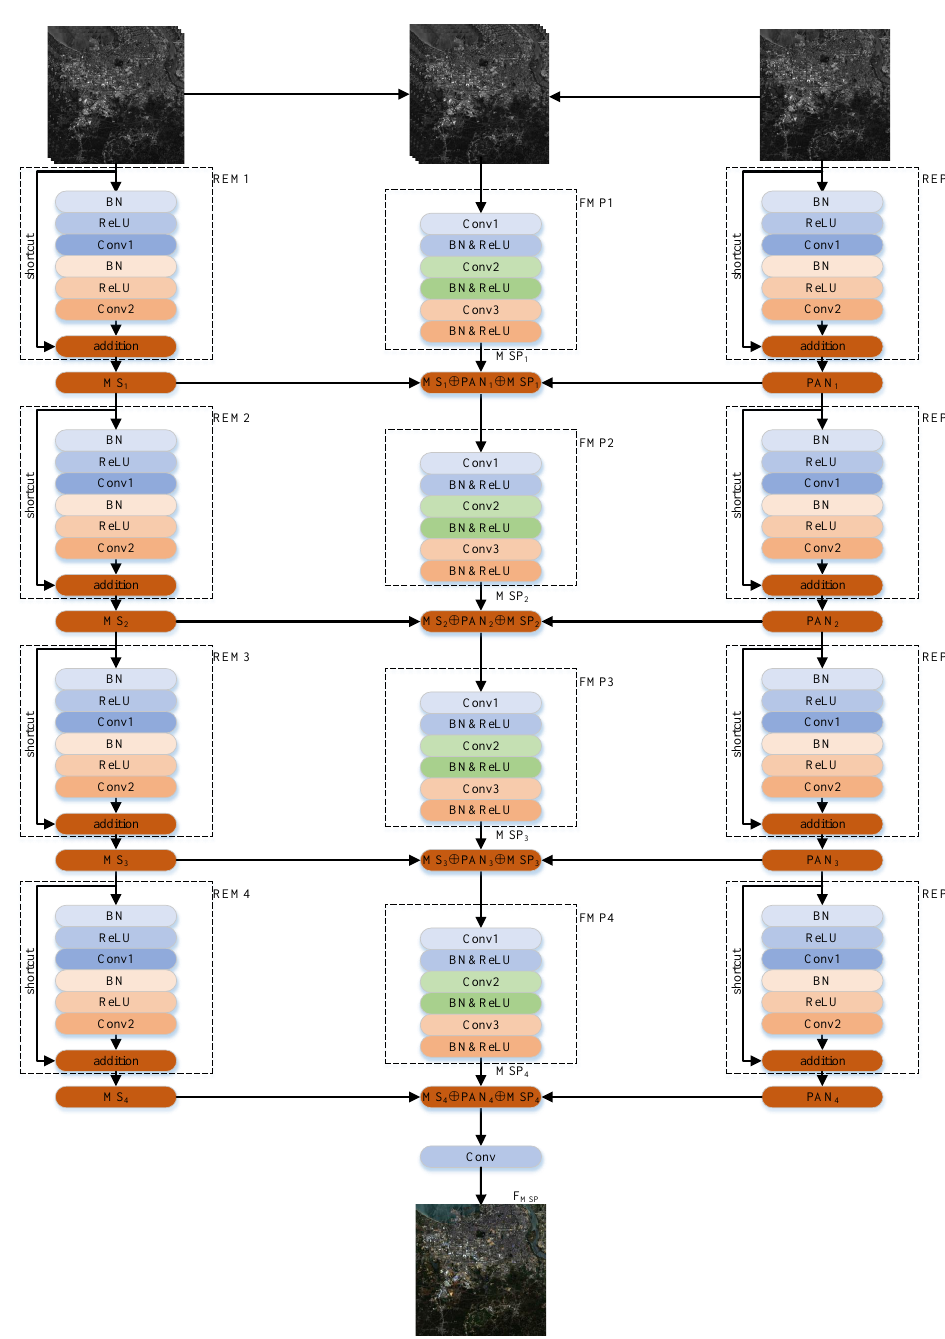
Figure 8. Proposed RDFNet for pan-sharpening. RDFNet is divided into three branches. The left branch is for multiscale feature extraction of MS image. The right branch is the multiscale feature extraction branch of PAN image. The middle branch is used for fusion of the two